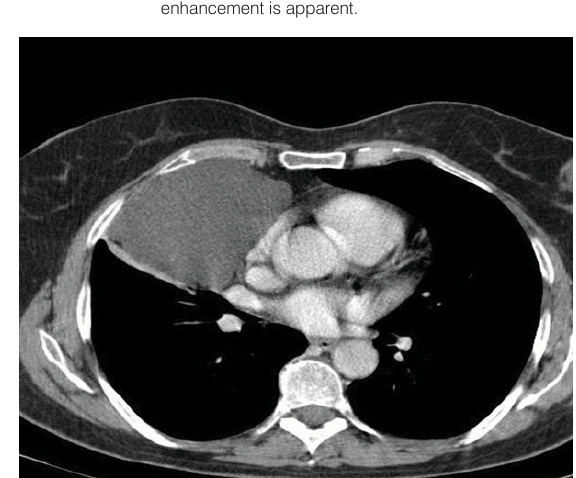
Figure 2. CT of the thorax after contrast application shows a well defined cystic mass in the anterior mediastinum with water density content. No septation or contrast enhancement is apparent.